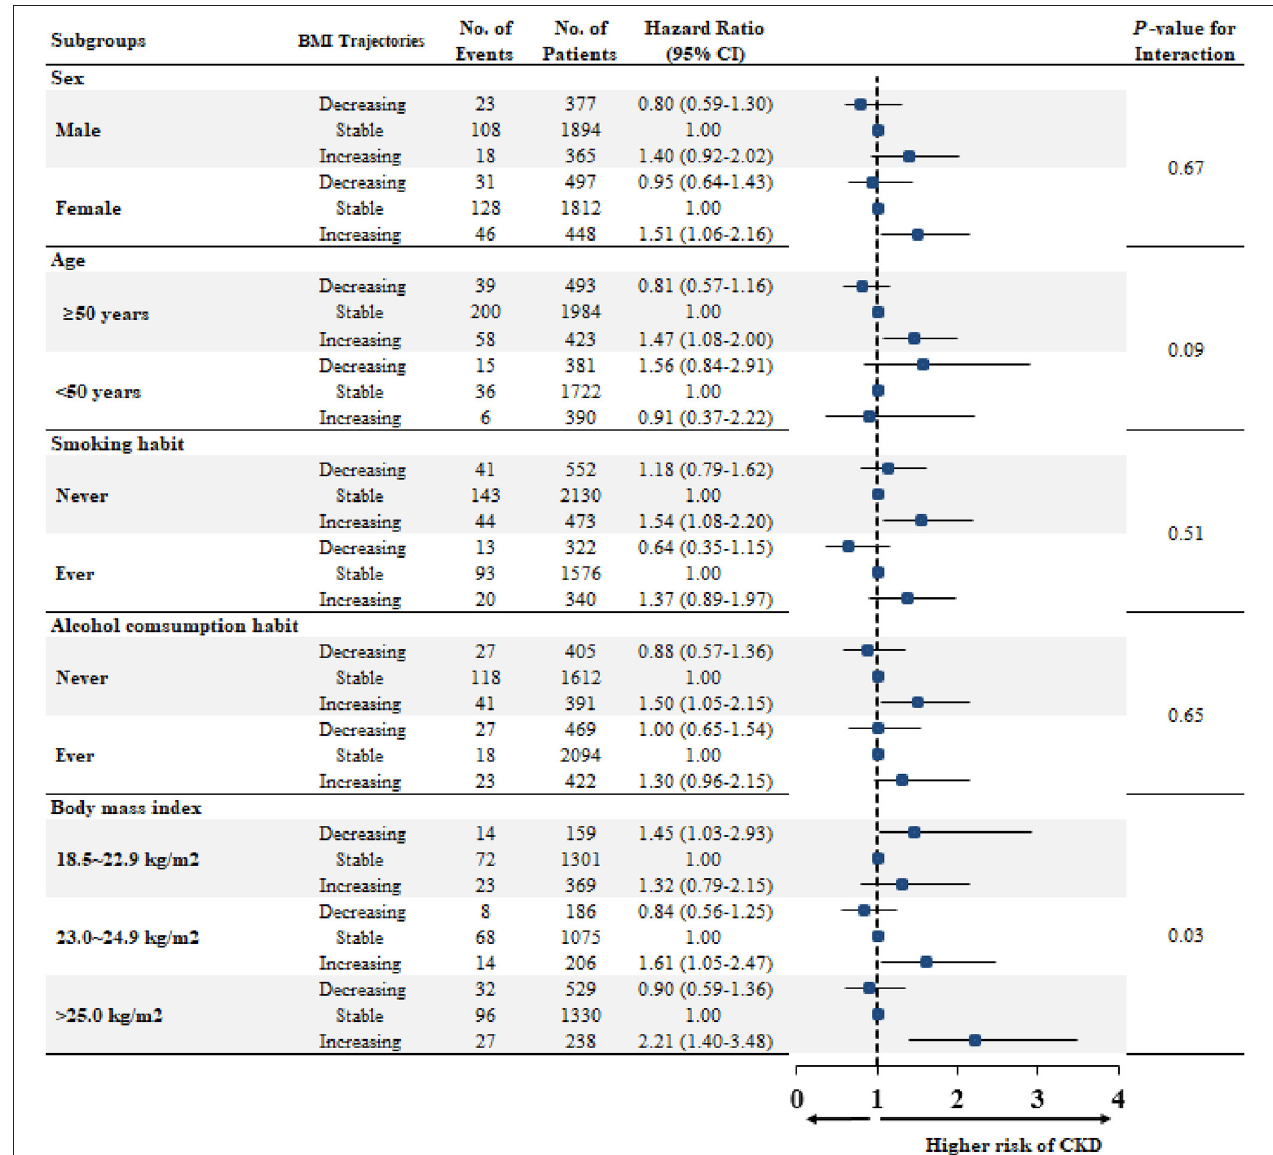
FIGURE 3 | Multivariable-adjusted hazard ratios for CKD developments according to trajectories, stratified by subgroups. Each HR and 95% CI were expressed after adjustment of covariates, including age, sex, the area of residence, smoking, alcohol consumption habit, income, education levels, body mass index, mean arterial pressure, hemoglobin, albumin, fasting glucose, estimated glomerular filtration rate, high-density lipoprotein-cholesterol, triglyceride, and high-sensitive C-reactive protein. BMI, body mass index; No, number; CKD, chronic kidney disease; HR, hazard ratio; CI, confidence interval.